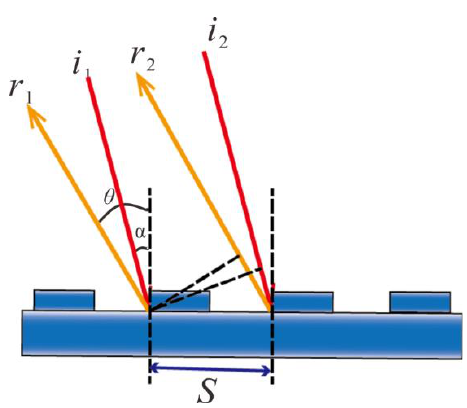
Figure 9. Linear grating in the case of reflection.